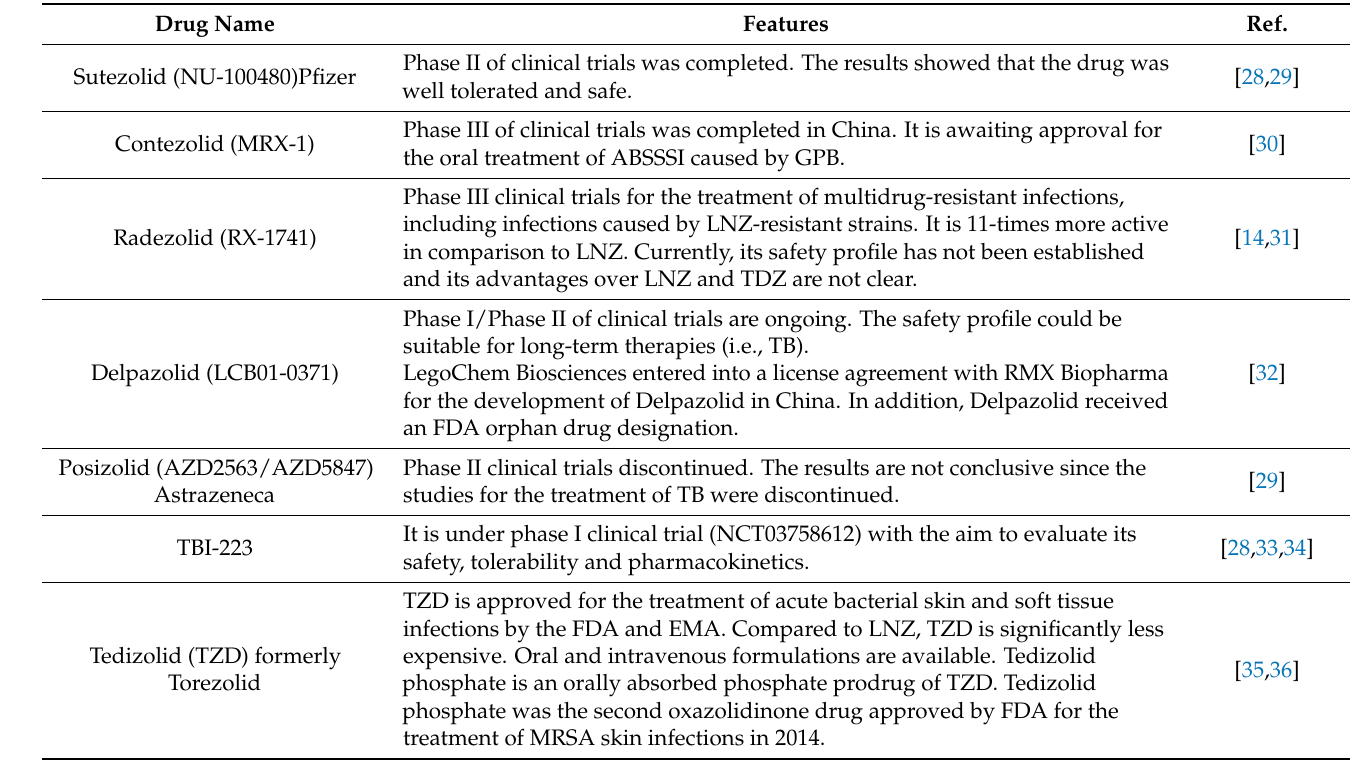
Table 1. The main representative oxazolidine antibiotics licensed or under